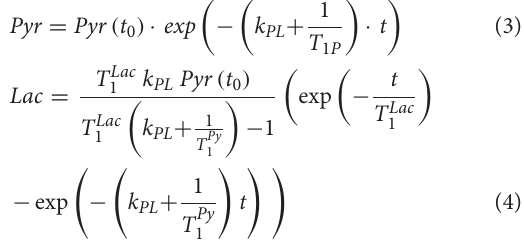
pyruvate and lactate that occurs in the intracellular compartment ( Figure 4 ). The lactate signal reached a maximum at about 20 s, and then decayed due to the T 1 relaxation processes. The 13